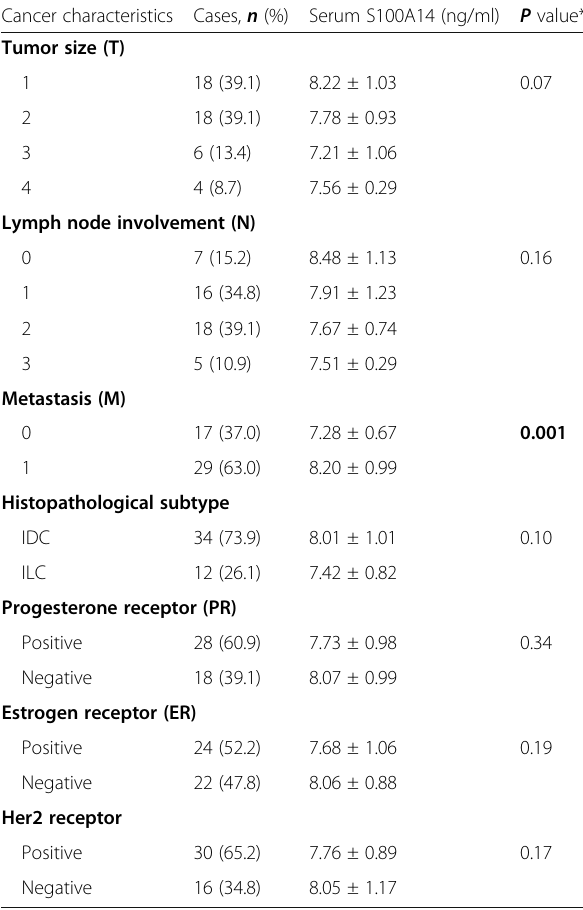
Table 1 Comparison of S100A14 serum levels in patients according to the cancer pathological features